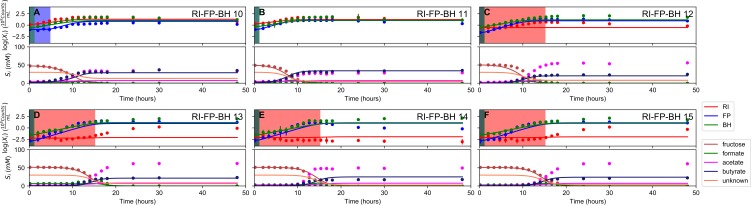
Fit to tri-culture experiments for the model parameterized on monocultures only.(A–B) Fit to tri-culture experiments dominated by Roseburia intestinalis L1-82 (RI) and Blautia hydrogenotrophica S5a33 (BH). (C–F) Fit to tri-culture experiments dominated by Faecalibacterium prausnitzii A2-165 (FP) and BH. Lines represent model predictions and dots represent observations. The whiskers represent technical variation across triplicates. The shaded regions indicate the length of the estimated strain-specific lag phases. The unknown compound represents an unspecified co-substrate assumed to be required by FP. Metabolites not included in the model are omitted from the plot. Experiment identifiers indicate which of the biological replicates is displayed. The model was parameterized on experiments RI_8, RI_14, FP_4, FP_15 and BH_14.